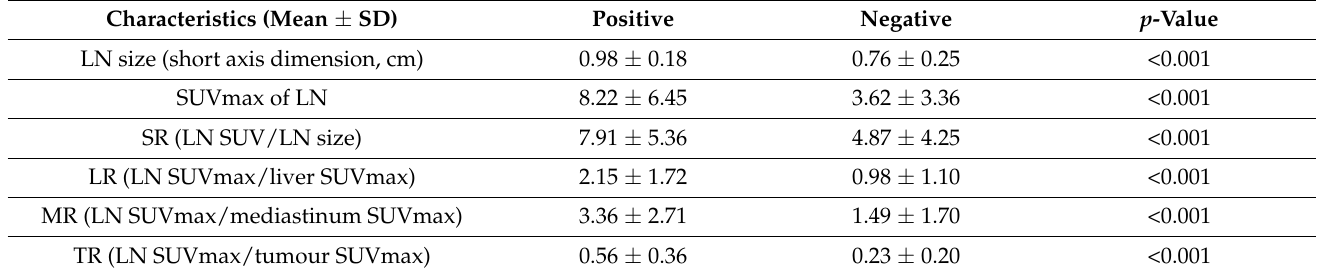
Table 3. CorrelationofnodalparameterswithmetastaticN2status(positiveornegativesignifiesthepresence or absence of metastatic disease in the lymph nodes based on histopathologic assessment,